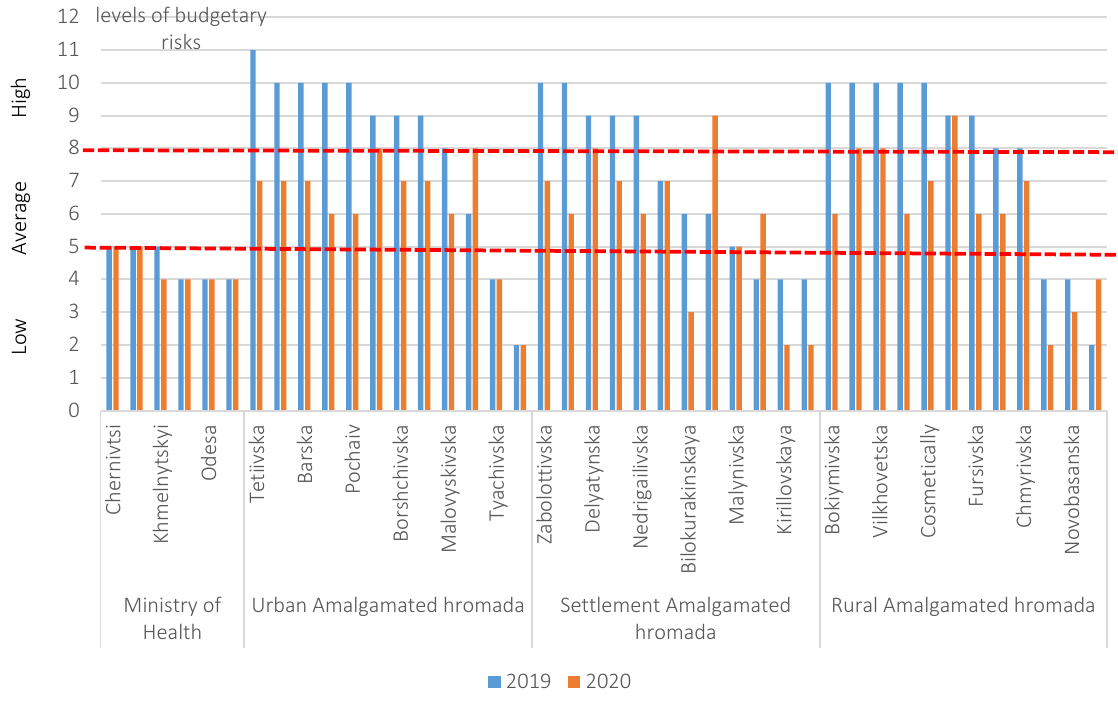
Figure 3. Budget risks of amalgamated hromada of Ukraine,